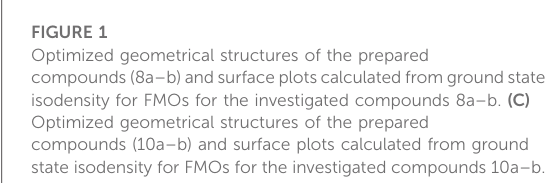
FIGURE 1 Optimized geometrical structures of the prepared compounds(8a – b)andsurfaceplotscalculatedfromgroundstate isodensity for FMOs for the investigated compounds 8a – b. (C) Optimized geometrical structures of the prepared compounds (10a – b) and surface plots calculated from ground state isodensity for FMOs for the investigated compounds 10a –